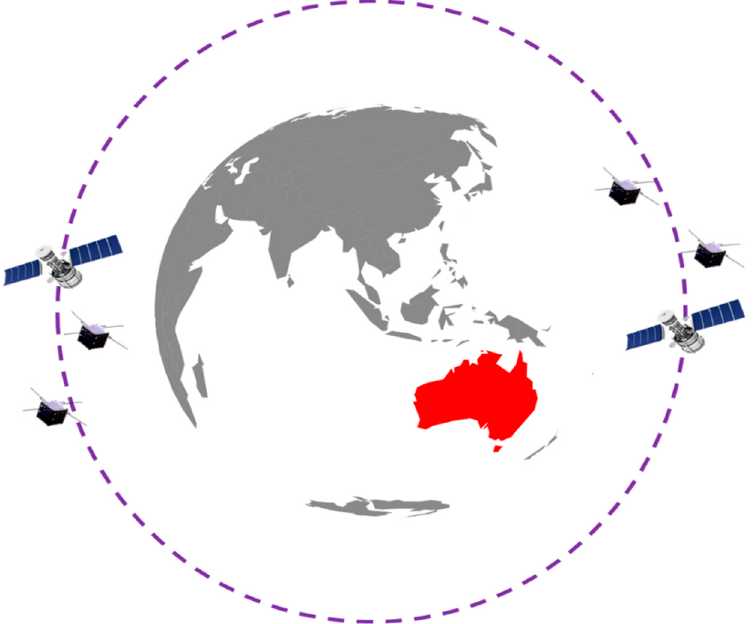
Figure 10. A constellation of two formations with three satellites.